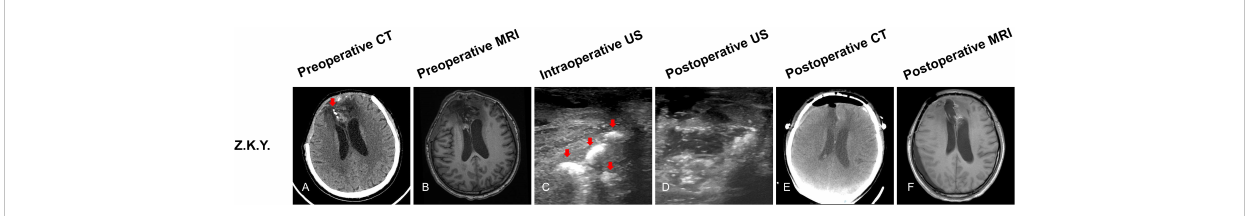
FIGURE 3 Illustrating case 2: Z.K.Y, a 50-year-old male patient, CT scan showed four high density (four tumors) located at the right frontal lobe ( A , red arrow). MRI (T1WI) sequences showed only one tumor (B) . Before opening the dura, ioUS revealed four hyperechoic signals (four tumors) in the operative fi eld ( C , red arrow). When the doctor used the ioUS to check the surgical fi eld after the resection, no tumor remnants were found (D) . The postoperative CT scan shows no tumor remnant (E) . The postoperative MRI (T1WI) scan reveals no signs of the tumor (F) . Recurrent WHO grade 2 oligodendroglioma was discovered by